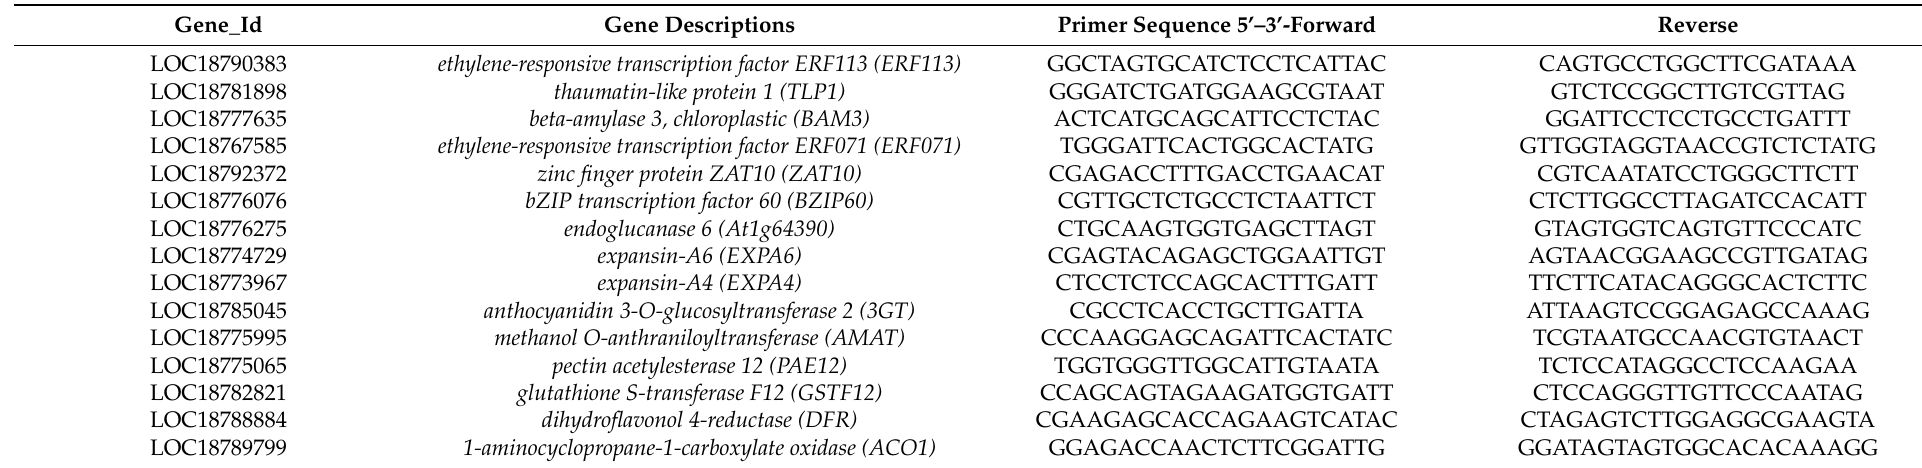
Table 3. Selected genes and primers used for validation of the transcriptome analysis with the quantitative